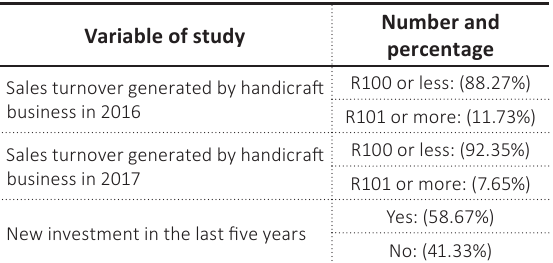
Table 4. Assessment of sales turnover ( n = 196)